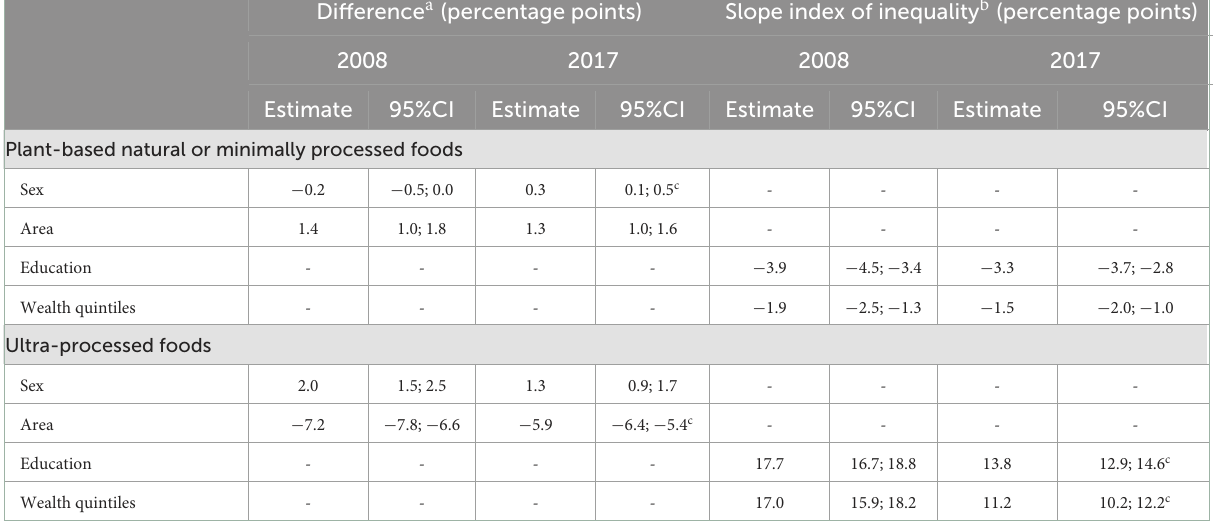
95%CI Estimate 95%CI